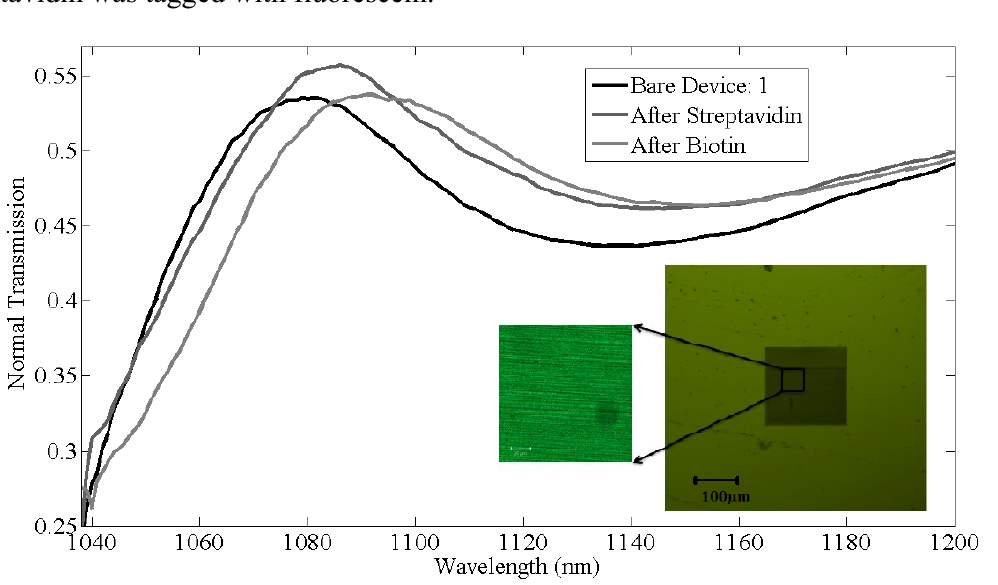
Figure 8. Measurements recorded on device 1 at different stages of immobilization with inset of confocal image of the device after functionalizing with biotin where the streptavidin was tagged with